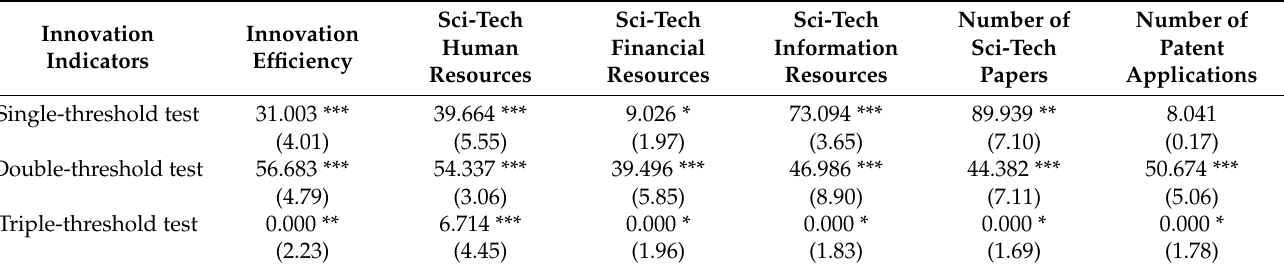
Table 2. The threshold effect